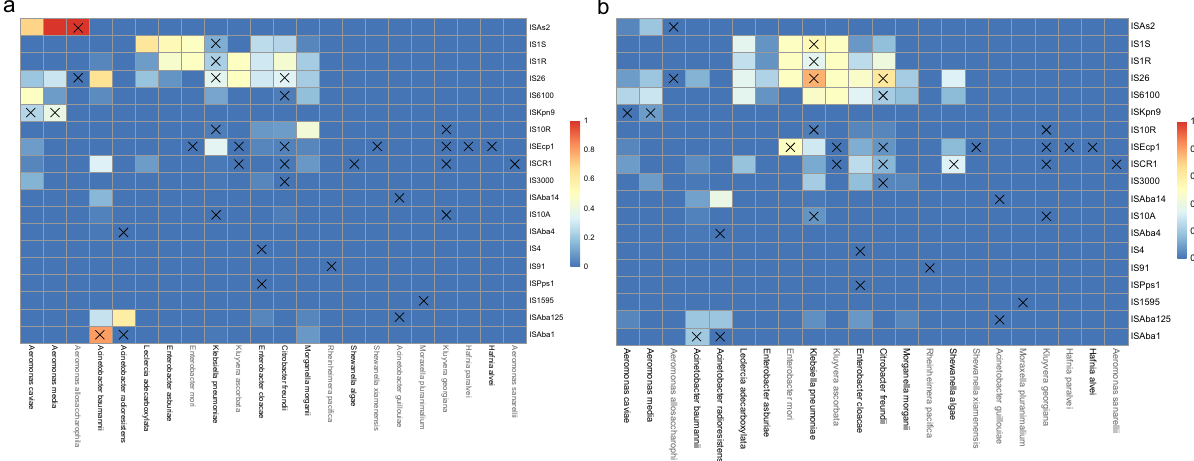
Fig. 2 Origin species ’ genomes carrying IS elements associated with mobilization from the corresponding species. Fraction of genomes (chromosome in ( a ) and plasmid in ( b )) carrying any of the IS elements showed to have been involved in mobilization of an antibiotic resistance gene (ARG) from the studied origin species. A cross indicates that the IS has likely been involved in the mobilization of an ARG from the corresponding species. A gray color of the species name indicates that there were fewer than fi ve genomes used in the